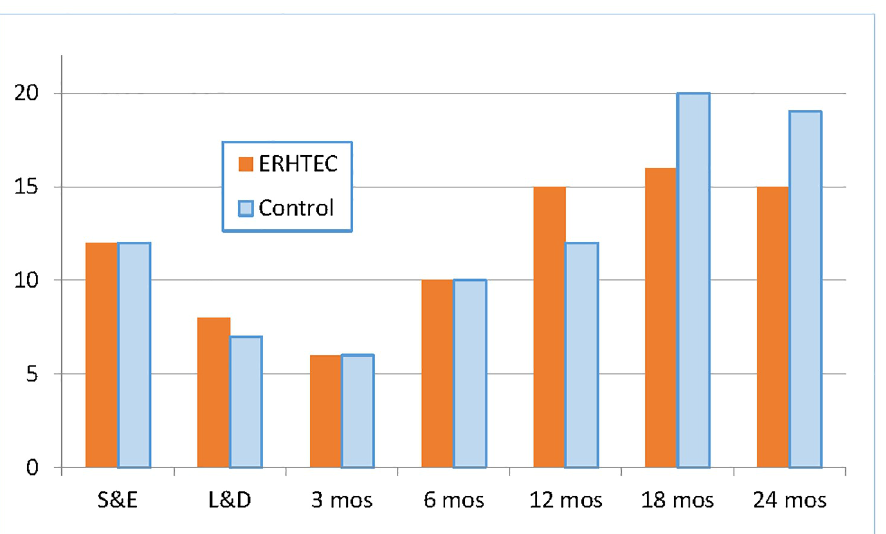
Fig 3. a. Proportion of sexually active women since last visit, by visit Difference in average change by treatment assignment: p = 0.120 Difference in average follow-up level by treatment assignment: p = 0.952 b. Median frequency of vaginal intercourse in the last 3 months, by visit Difference in average change by treatment assignment: p = 0.615 Difference in average follow-up level by treatment assignment: p =